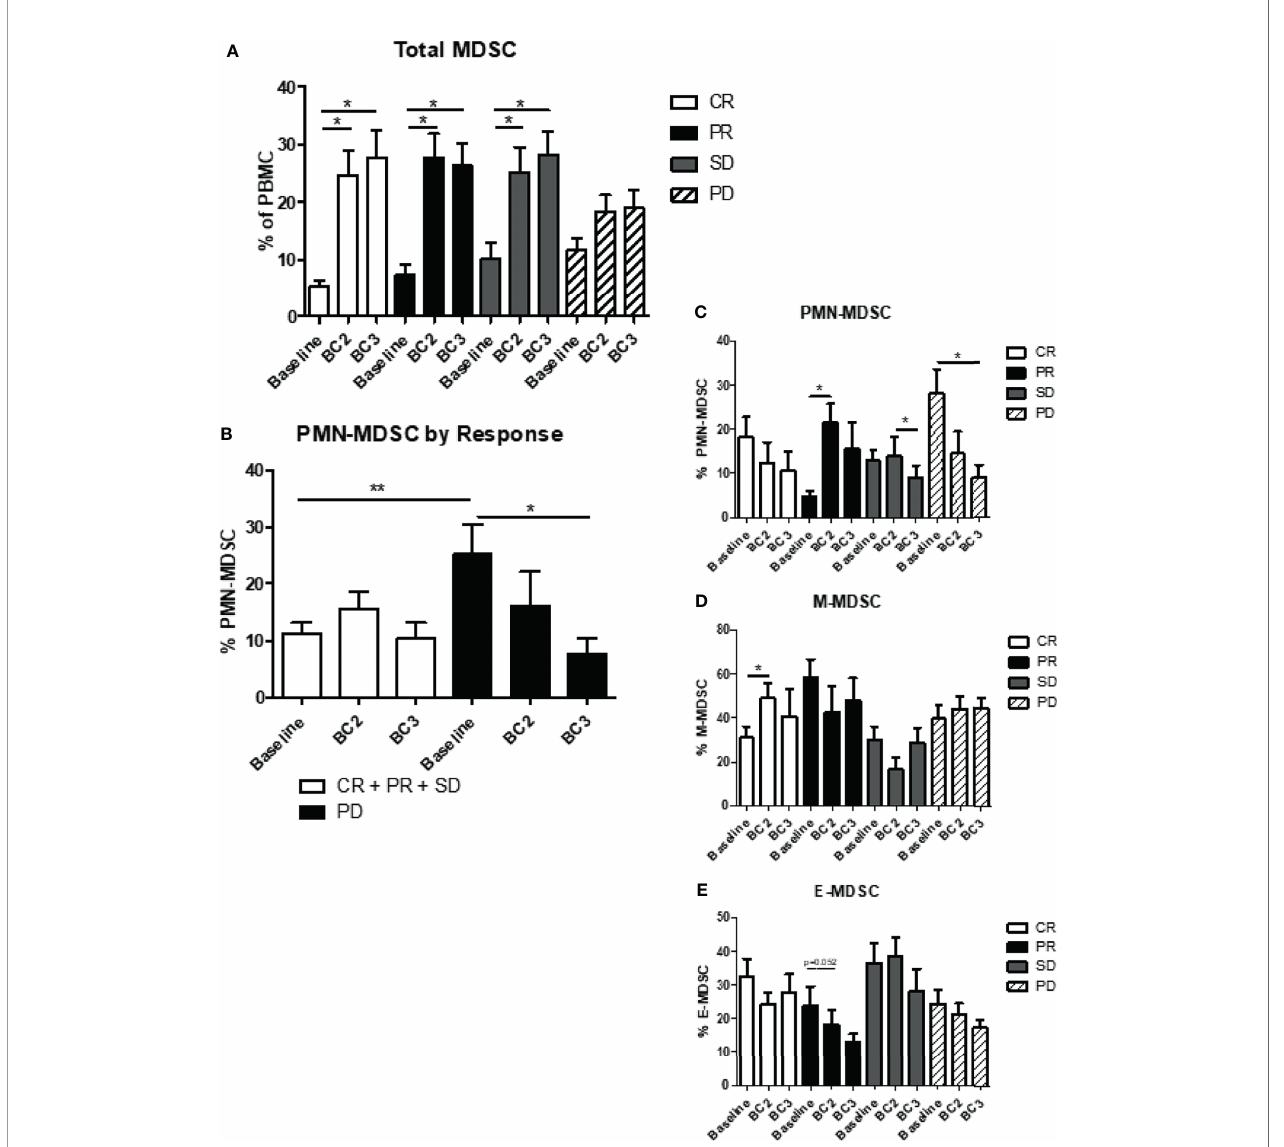
FIGURE 4 | Myeloid-derived suppressor cells and response to immunotherapy. Patient MDSC levels were evaluated according to immunotherapy response, namely clinical bene fi t (CR + PR + SD) or progressive disease (PD). (A) Levels of total MDSC grouped by patient response to immunotherapy. (B) Levels of granulocytic (PMN-MDSC) in the two response categories are shown. Levels of (C) PMN-MDSC, (D) monocytic MDSC (M-MDSC) and (E) early MDSC (E-MDSC). Data are shown as mean ± SE, *p < 0.05, **p < 0.01. CR, complete response; PR, partial response; SD, stable disease; and PD, progressive